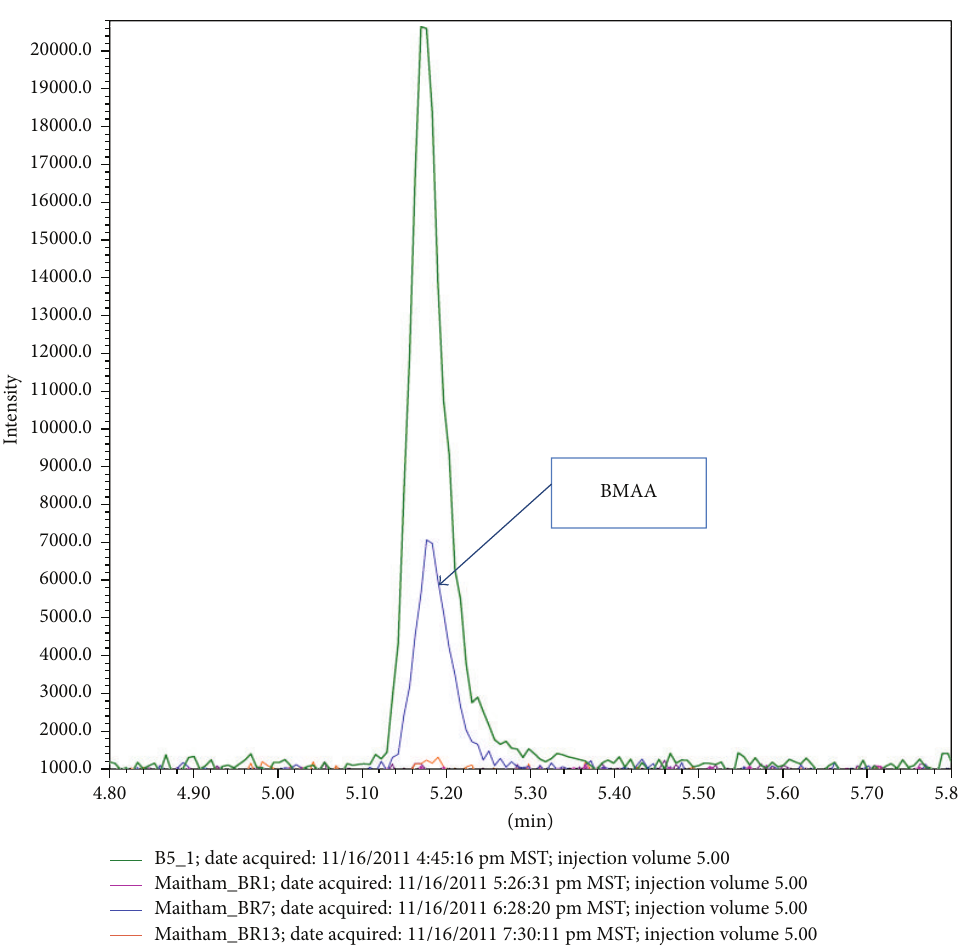
Figure 2: UPLC chromatography of L-BMAA level (4.66 𝜇 g/g) in brain of male mouse with dose 3 mg/g BW.